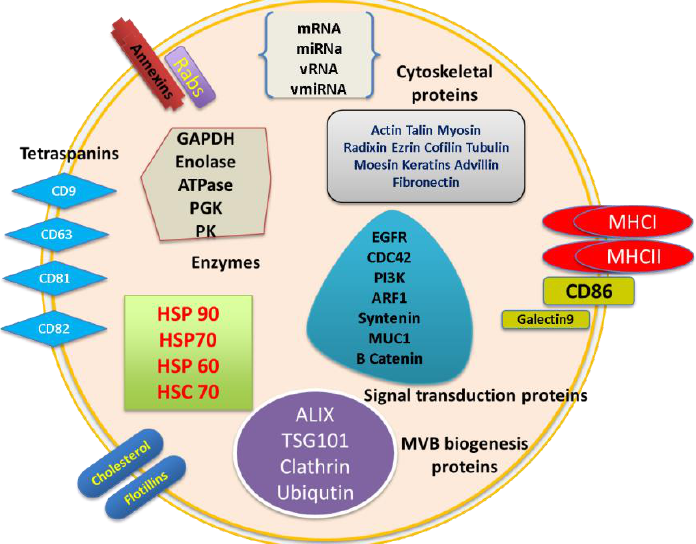
Figure 1. Structure and composition of exosomes. Exosomes contain a plasma membrane- derived phospholipid bilayer membrane. The composition depends on the cell type of origin, state of health of the host, and extracellular stimuli. Exosome contents include mRNA, miRNA, DNA, and proteins like annexins, tetraspanins, Alix, TSG101, MHC molecules, Rab proteins, cytoskeletal proteins, enzymes, and signal transduction proteins.